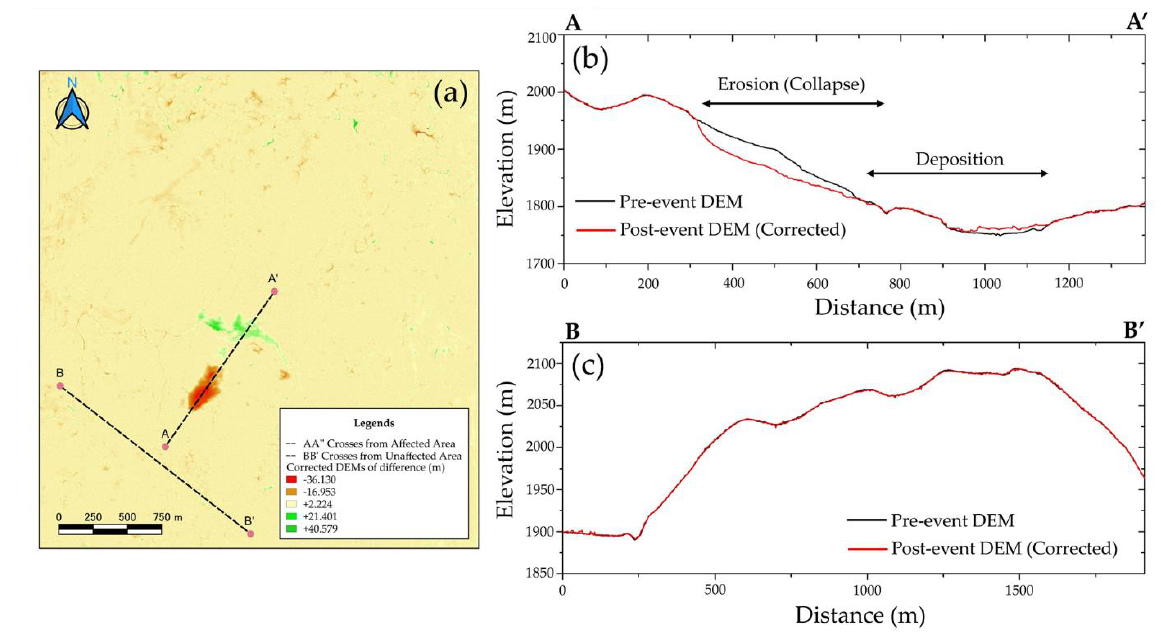
Figure 14. ( a ) Corrected DoD with the A-A’ and B-B’ cross-section lines. ( b ) Profile cross-section line (A-A’) passing through the affected area. ( c ) Profile cross-section line (B-B’) passing through the unaffected